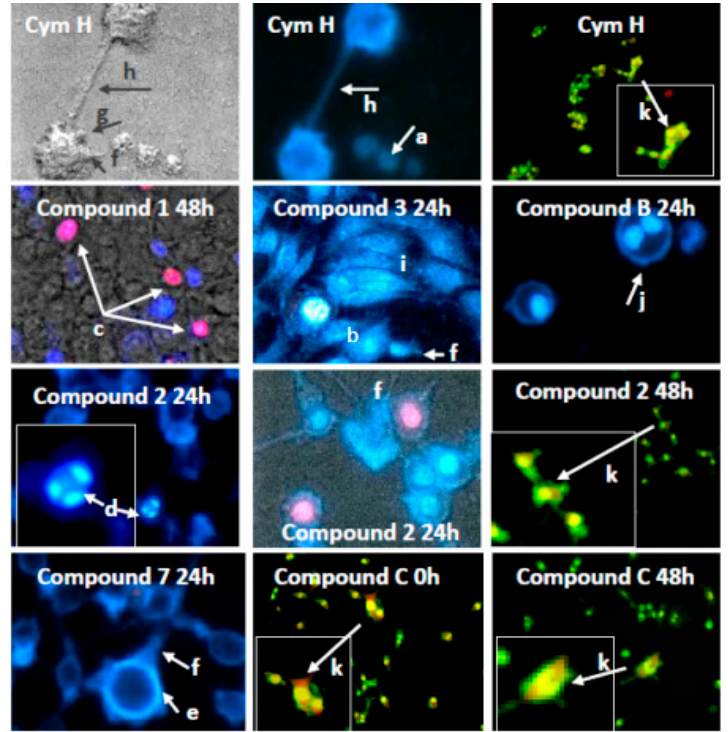
Figure 5. Example enlarged photomicrographs illustrating induction of apoptosis, autophagy and mitotic catastrophe in human ovarian adenocarcinoma cells SKOV-3 by cymantrene derivatives 1 , 2 , 3 , 7 , B , and C and their core precursor CymH . The cells were stained with acridine orange (AO) and double-stained with fluorescence dyes Hoechst 33258 (Ho33258) and propidium iodide (PI) and then analyzed with an inverted fluorescence microscope (Olympus IX70, Tokyo, Japan) at 400× magnification, except cells stained with AO, which were photographed under 150× magnification. The images marked with arrows show the most typical morphological changes associated with different type of cell death induced by cymantrene compounds during 24 h-treatment and following culture of SKOV-3 cells in drug-free medium for 24 or 48 h (0 h—cells examined immediately after the treatment): ( a ) pale-blue live cells; ( b ) intense bright-blue early apoptotic shrunk cells with pycnotic nucleus; ( c ) violet late apoptotic cells; ( d ) cells with highly condensed and fragmented chromatin (karyorrhexis) ; ( e ) marginalization of chromatin; ( f ) cells with plasma membrane protrusions (“blebs”); ( g ) apoptotic bodies; ( h ) cytoplasmic bridges between the cells. Presence of giant cells ( i ), polyploid cells with two nuclei ( j ) and cells with AVOs ( k ) suggest concomitant mitotic catastrophe and autophagy, respectively.